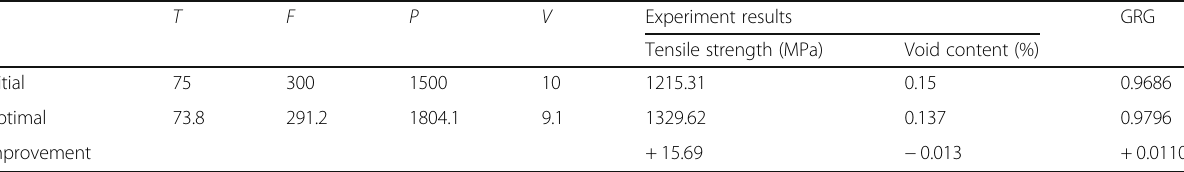
Table 5 Comparison between the initial and optimal